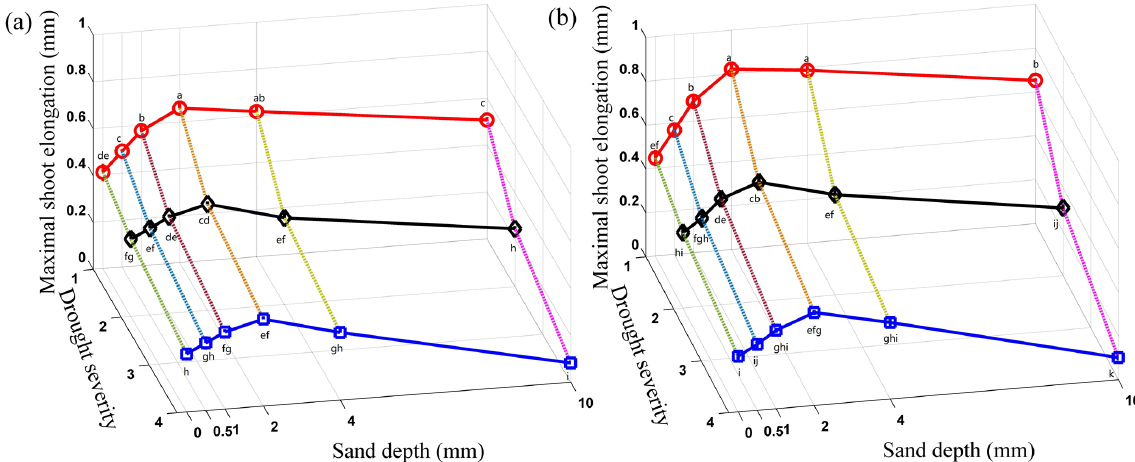
Figure 5. Changes in the maximal shoot elongation of the biocrust moss Bryum argenteum Hedw. following exposure to natural precipitation (control; 1), half of the natural precipitation amount (2), and one-fourth of the natural precipitation amount (4), combined with 0 (control), 0.5, 1, 2, 4, and 10mm depth of sand burial in spring (a) and autumn (b) . Symbols represent means ± SE. Different letters indicate significant differences between different drought severities and sand burial depth treatments at the p < 0 . 05 level as determined using an LSD post hoc